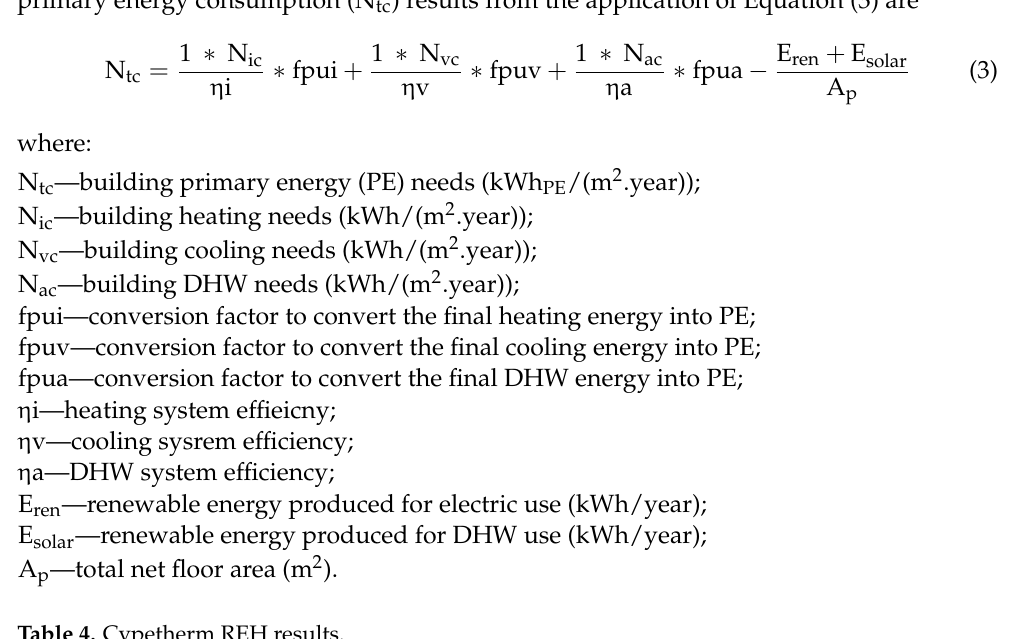
Table 4. Cypetherm REH